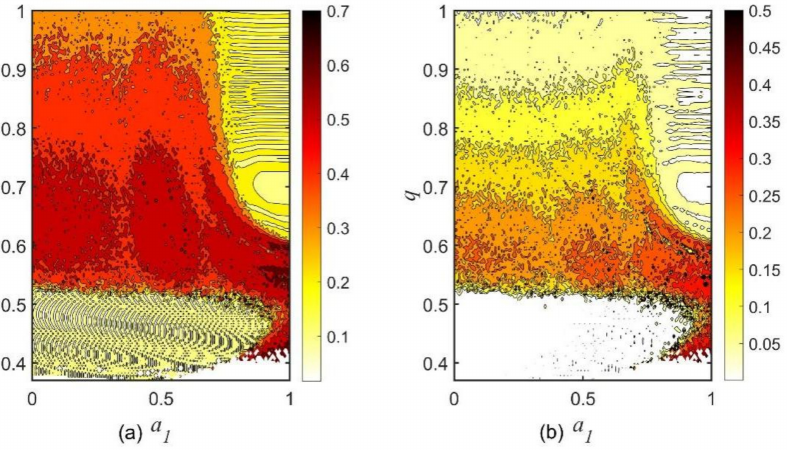
Figure 8. Complexity contour plot of system (14) in the q − a 1 plane. ( a ) C 0 contour plot. ( b ) SE contour